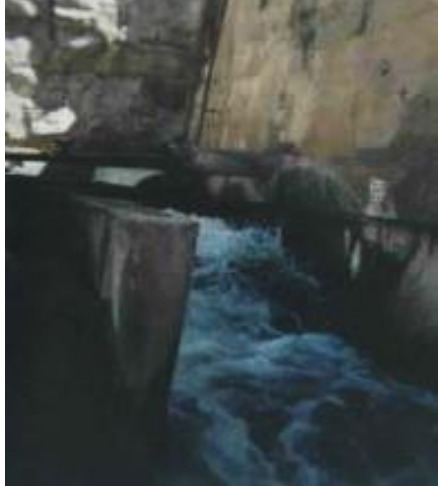
Figure 7. Flooding of the lower